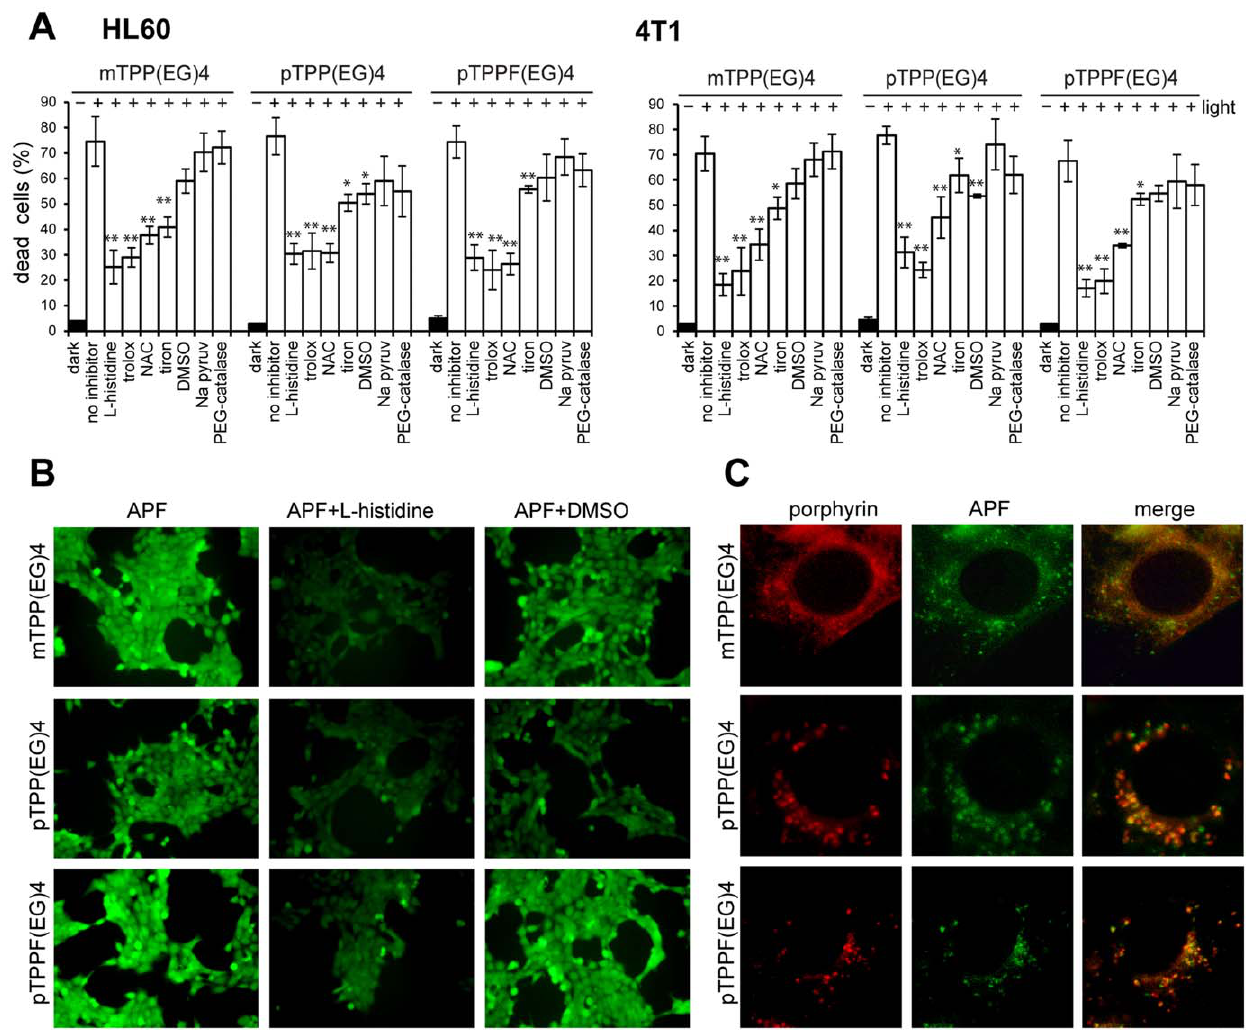
Figure 3. Role of ROS generation in EG-porphyrin-mediated cell death. ( A ) Effect ROS scavengers on cell viability after PDT. 4T1 cells were loaded with EG-porphyrin derivatives for 16 h, washed and then pre-incubated for 1 h with L-histidine (20 mM), trolox (5 mM), NAC (15 mM), tiron (10 mM), DMSO (1%), PEG-catalase (300 U/ml) and sodium pyruvate (Na Pyruv) (10 mM) before light exposure. Similarly, HL60 cells were pre- incubated with L-histidine (20 mM), trolox (4 mM), NAC (5 mM), tiron (10 mM), DMSO (1%), PEG-catalase (300 U/ml) and sodium pyruvate (Na Pyruv) (10 mM). After irradiation the cells were further cultivated and cell viability was determined 24 h post-PDT by the trypan blue exclusion method. Cells treated with EG-porphyrin derivatives without irradiation were used as controls (dark). The percentage of dead cells was expressed as the mean 6 SD (n=3). *P , 0.050, ** P , 0.01 represents statistical differences between PDT-treated cells vs. PDT-treated cells in the presence of L-histidine, trolox, NAC, tiron and DMSO. ( B ) ROS detection. 4T1 cells incubated with EG-porphyrin derivatives were washed and loaded with 10 m M APF(3 9 -(p- aminophenyl) fluorescein) in the presence or absence of L-histidine (20 mM) or DMSO (1%) for 30 min. Dye-loaded cells were then stimulated with UV light for 10 s under a DM IRB microscope (Leica) and fluorescence images were acquired immediately using a 6 10 objective. ( C ) In situ detection of ROS generation. 4T1 cells grown on coverslips were sequentially loaded with porphyrin derivatives and APF probe. After 30 min incubation with the APF probe cells were exposed to UV light for 10 s and fluorescence images were acquired immediately using a 6 63 objective. Fluorescent images of EG-porphyrin derivatives (left panels), APF probe (middle panels) and their overlay (right panels). Scale bars: 10 m m.